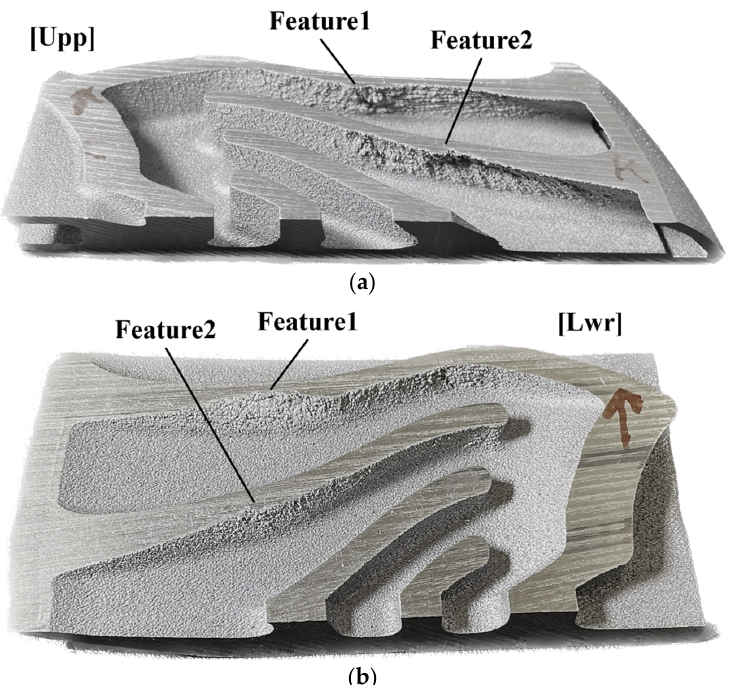
Figure 22. Segmented sample 2 and named features: ( a ) upper region of segmented sample 2 and two collapse regions, feature1 and feature2; ( b ) lower region of segmented sample 1 and two collapse regions, feature1 and feature2.